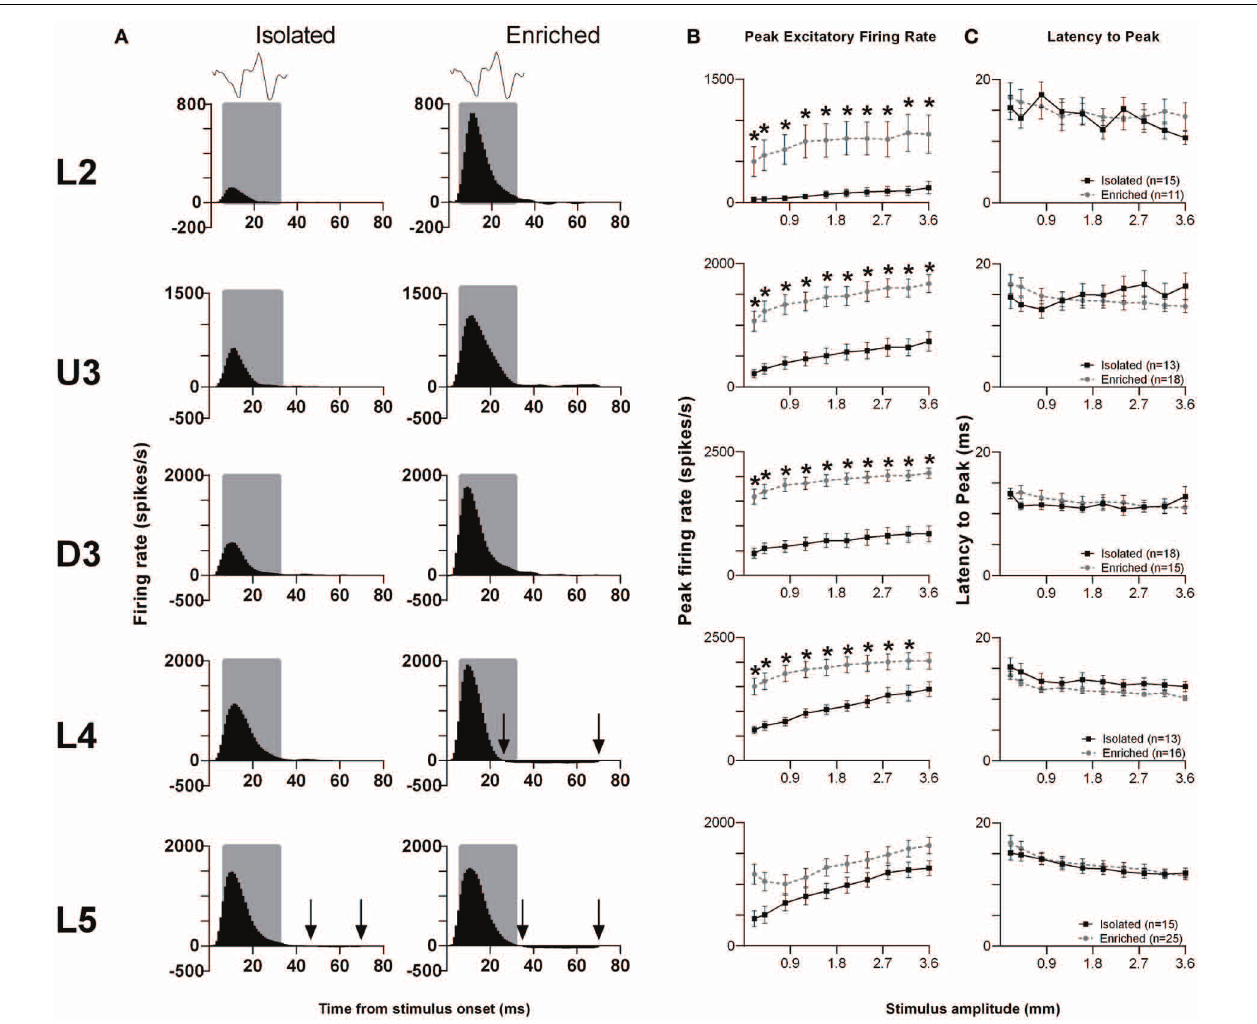
FIGURE 4 | EE effects on pattern, strength and timing of responses evoked by the rough surface discrimination stimulus. Significant increases in response strength were found in L2–4 after EE (but not L5), with no changes in response timing. (A) Population Grand PSTHs in response to the trapezoid with the fastest onset ramp velocity (400mm/s) in a specific lamina (indicated to left of panel) in EE and Isolated animals. Laminar designations: L2, Layer 2; U3, Upper Layer 3; D3, Deep Layer 3; L4, Layer 4; L5, Layer 5. Each Grand PSTH was generated by averaging responses across all responsive clusters in that lamina. The analysis window used to extract